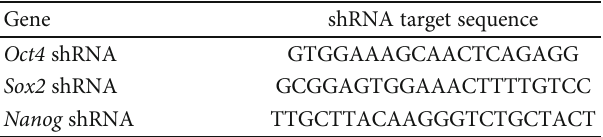
Table 2: Targeting sequences of shRNAs.